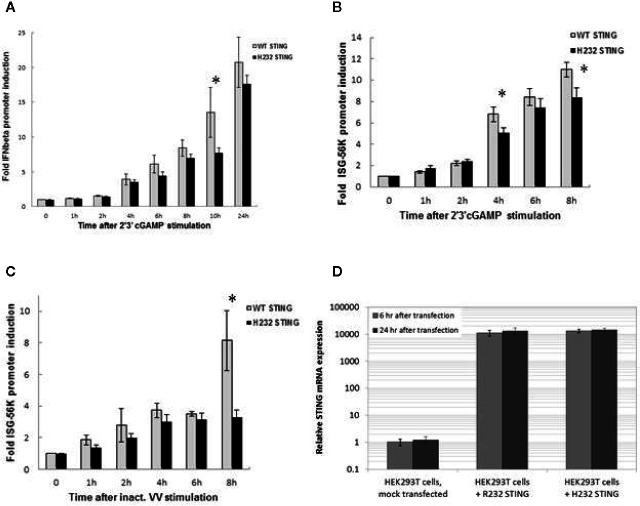
IFNβ and ISG-56K Promoter Activity is Greater in HEK 293T Cells Stably Expressing the R232 STING Variant. (A) IFNβ promoter induction following cGAMP stimulation. (B) ISG-56K promoter activity after cGAMP stimulation. (C) ISG-56K promoter activity after stimulation with inactivated vaccinia virus (inact. VV). Data points for (A), (B, C) show the means with error bars representing the standard deviations of three replicates. (D) STING expression in HEK293T stably expressing R232 or H232 STING. Data points for (D) show the means with error bars representing the standard deviations of eight replicates. A two-tailed t-test* detected significant differences; see text for p-values. Each experiment was performed twice with nearly identical results.